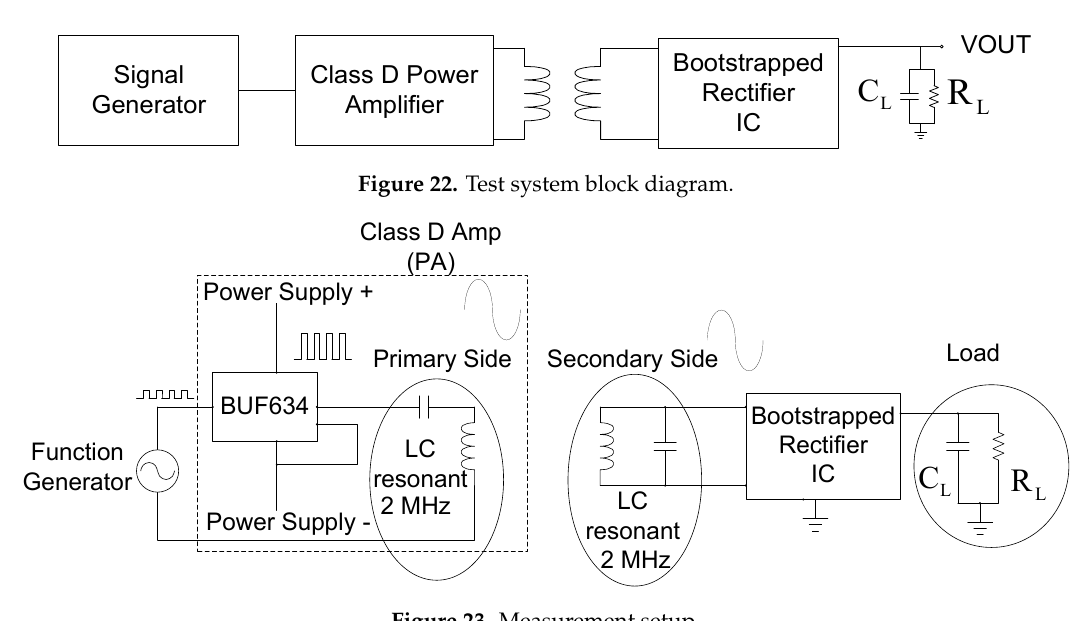
Figure 23. Measurement setup.